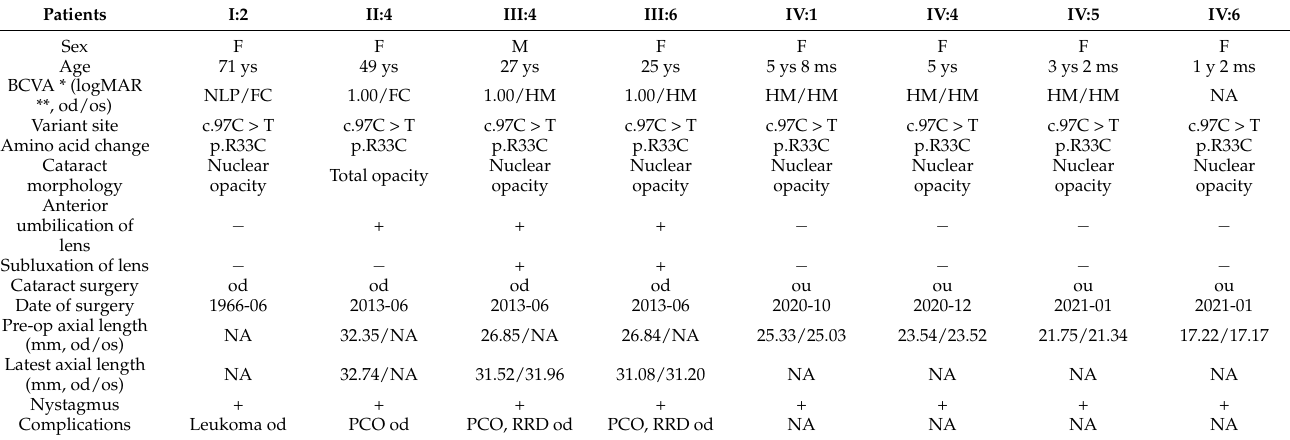
Figure 1. The pedigree of a four-generation family and sequencing results of the MIP genetic variant. ( A ) In the pedigree of a congenital cataract family with variant NP_036196.1:p.R33C of the MIP gene, the black arrow indicates the proband. ( B ) Sequence maps of the involved sequence fragment of the MIP show a heterozygous C > T transition at position 97 (red arrow). IV:4, the proband, IV:3, the unaffected member. Table 1. Summary of clinical features and genetic variants of patients with congenital